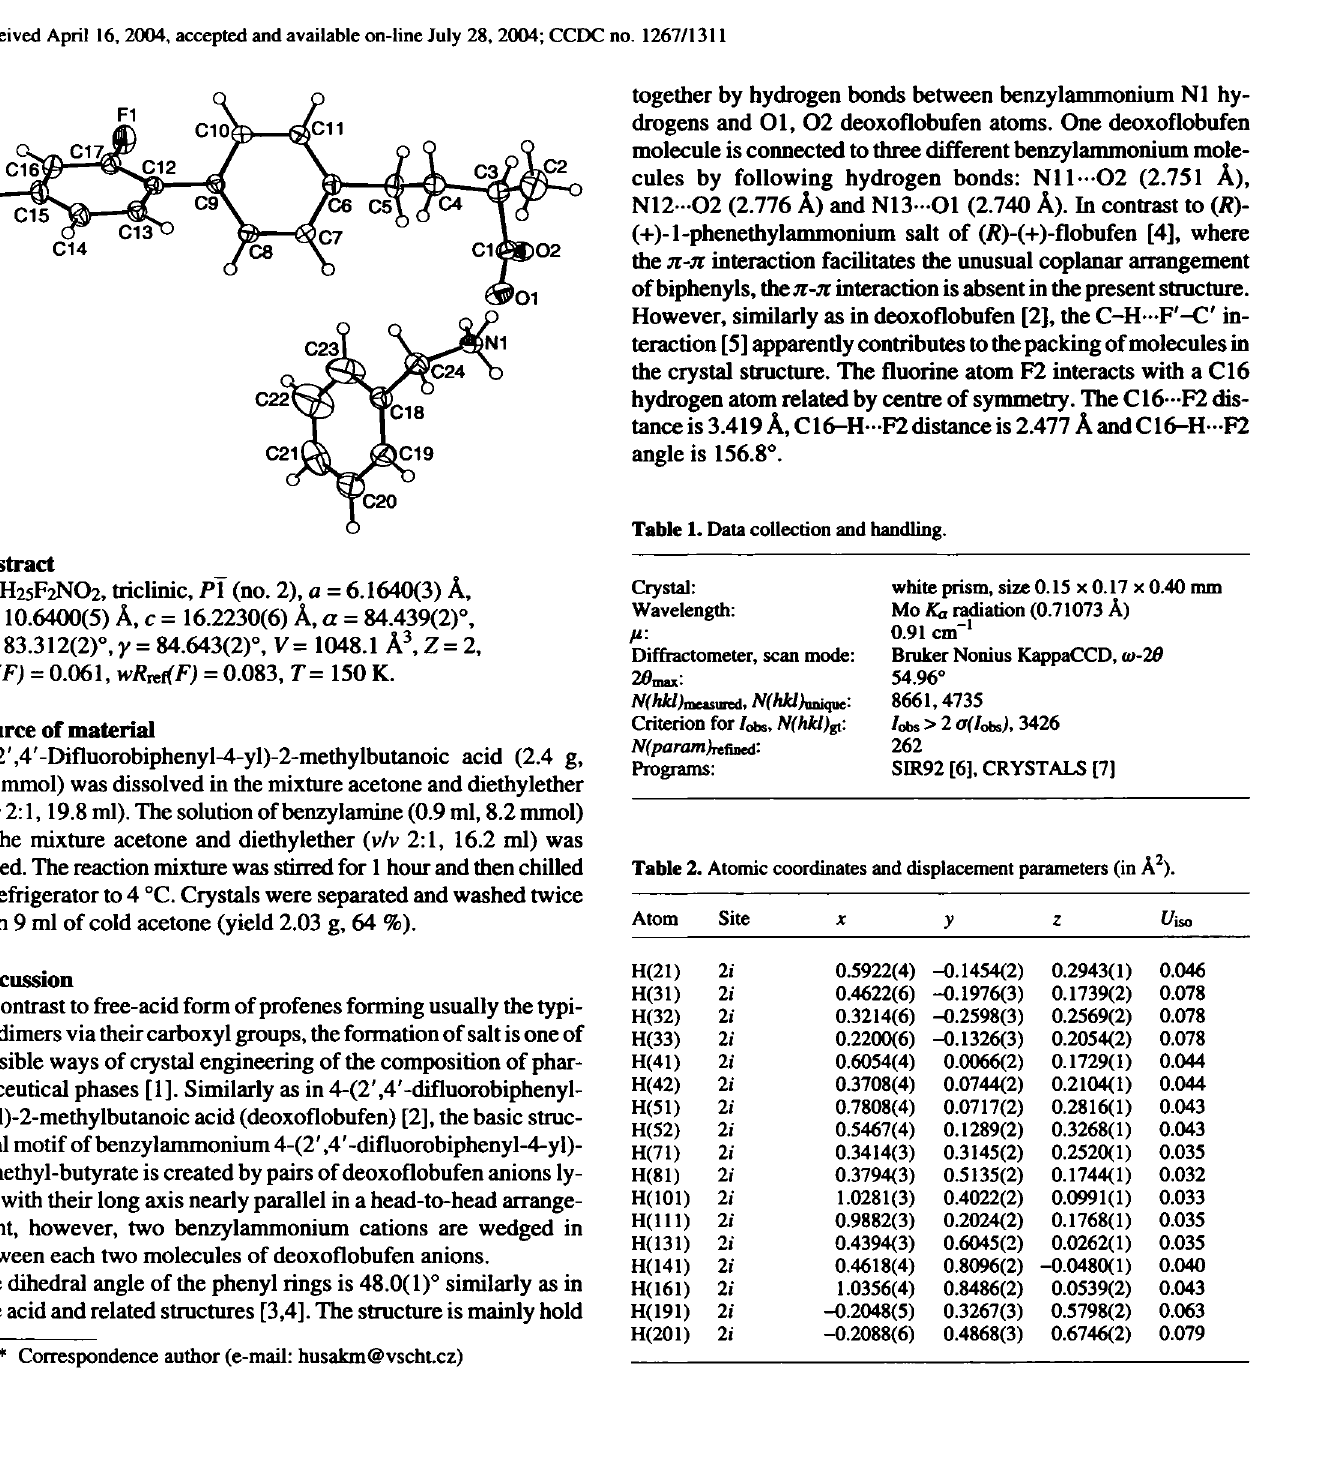
Table 2. Atomic coordinates and displacement parameters (in A 2